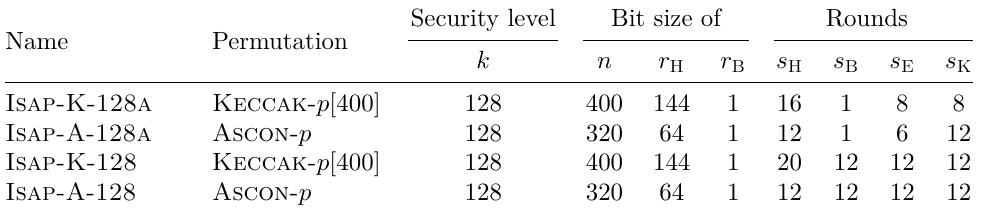
Table 1: Recommended parameter configurations for Isap .